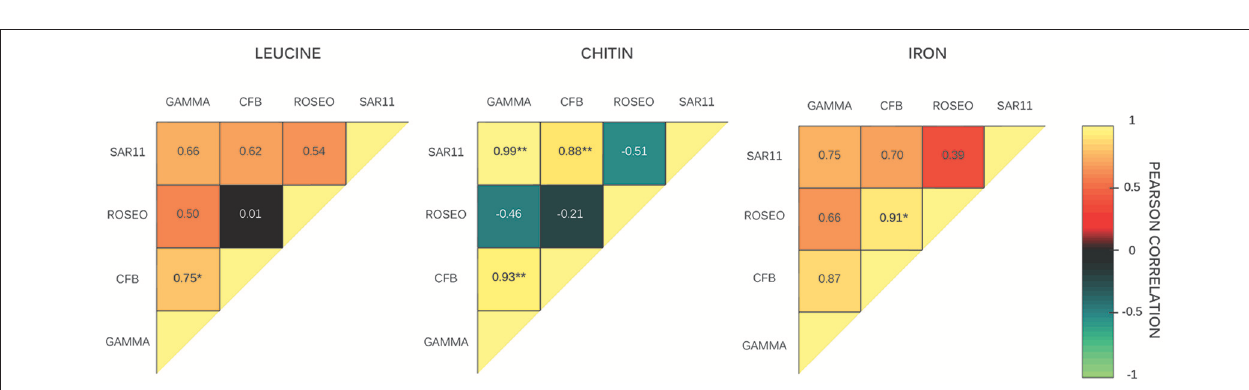
FIGURE 5 | Pearson correlations between the fractions of substrate active cells among bacterial groups for the three different compounds at 4 stations. GAMMA, Gammaproteobacteria; CFB, Cytophaga/Flexibacter/Bacteroides ; ROSEO, Roseobacter clade; SAR11, SAR11 cluster. Pearson correlation value is indicated inside each box. Correlations among groups that are statistically significant at 95 or 99% of confidence level are marked with one or two asterisks,